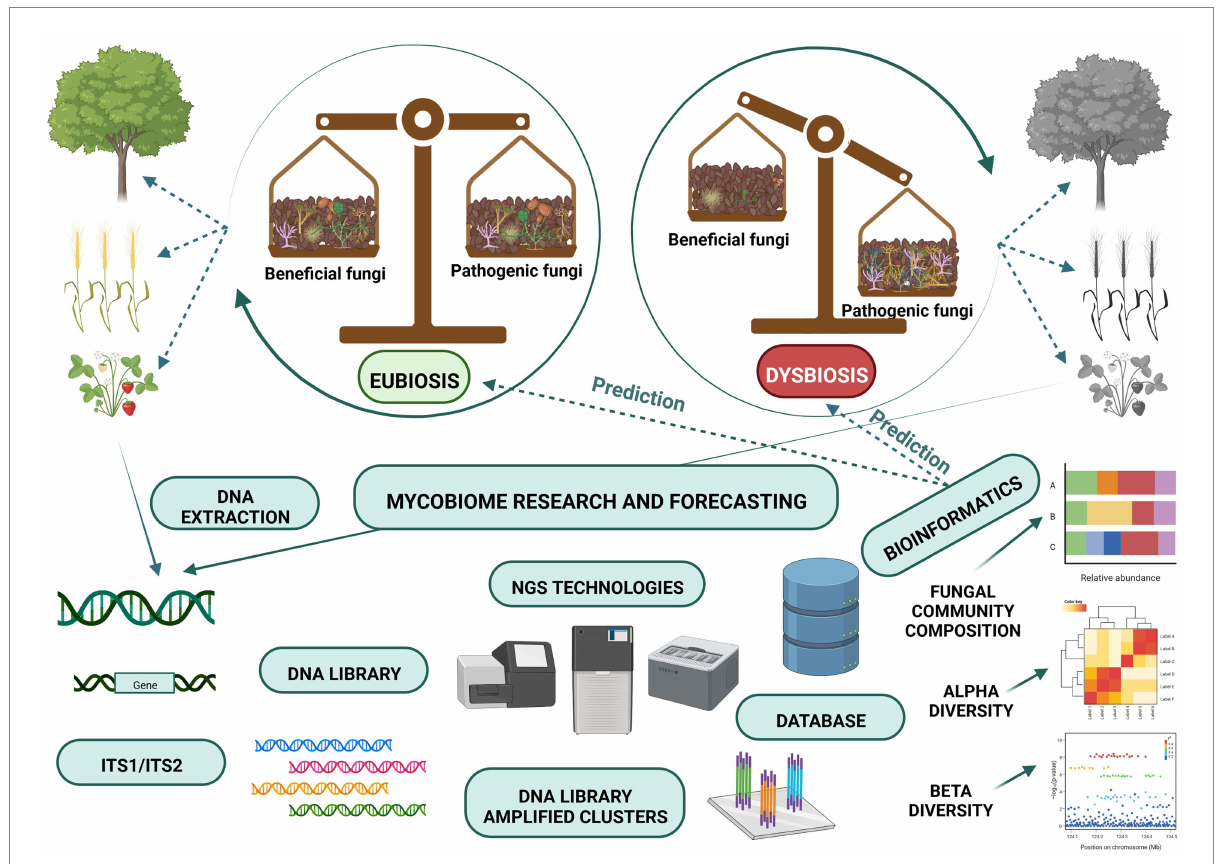
FIGURE 2 Next Generation Sequencing and bioinformatic programs are modern tools for the monitoring of soil mycobiome